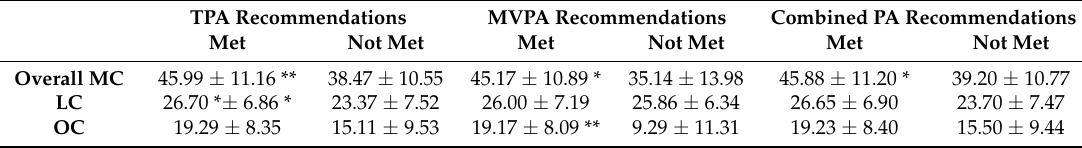
Table 3. Mean ( ± SD) MC in children who met and did not meet PA